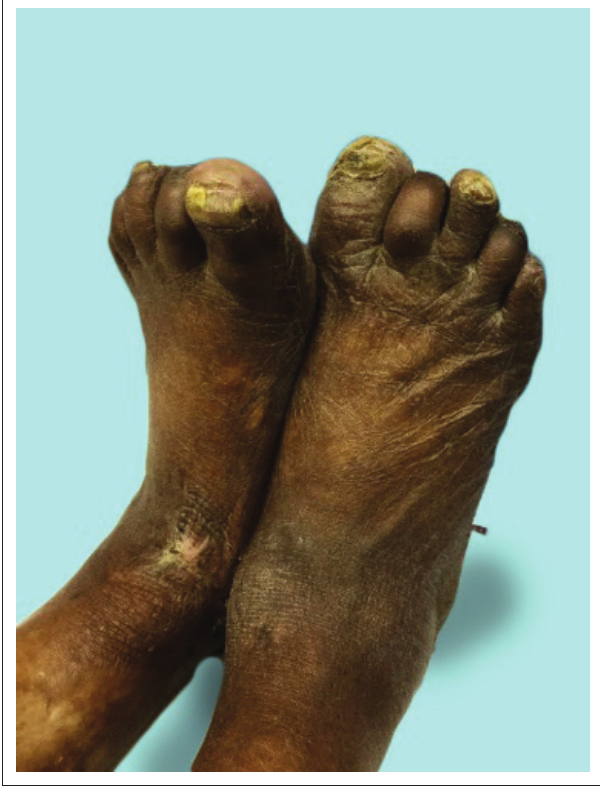
FIGURE 4: Peripheral neuropathy with secondary nail dystrophy.